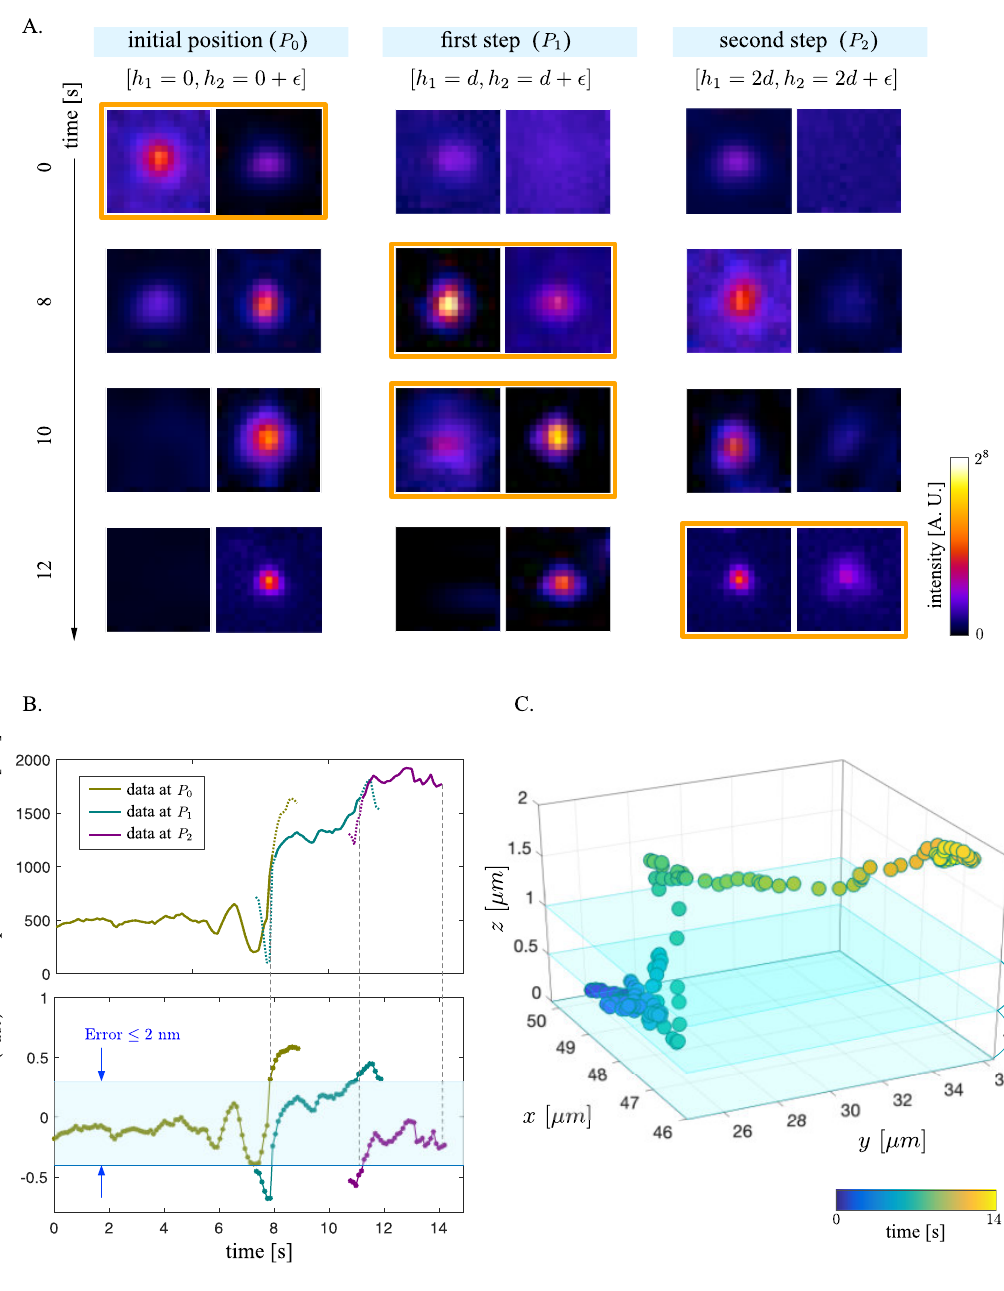
Figure 6. ( A ) Quantum-dot-labeled vesicle on each focal plane at three different positions of the objective lens. ROI size of each image is 17 × 17 pixels. The image sets enclosed within the orange boxes were analyzed to evaluate axial position of the vesicle. Here, h 1 and h 2 represent the positions of the two focal planes according to the axial position of the objective lens: P 0 , P 1 , or P 2 ; ( B ) Concatenated axial positions of the vesicle over time. Only the I det range, which had a detection error smaller than 2 nm, was chosen to evaluate the axial position of the vesicle; ( C ) Vesicle trajectory reconstructed in three